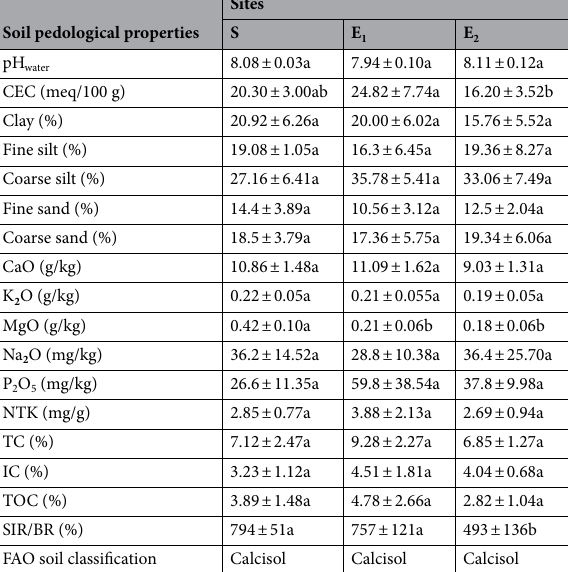
Table 1. Soil pedological properties (mean ± standard deviation) of the studied sites measured between 0 and 10 cm depth and FAO soil classification. Means (n = 5) followed by different letters are significantly different (Wilcoxon test. p ≤ 0.05). Sites: S = reference site at Sormiou. E 1 = Escalette 1 and E 2 = Escalette 2. Parameters: CEC = cation exchange capacity; NTK = total Kjeldahl nitrogen; TC = total carbon; IC = inorganic carbon; TOC = total organic carbon; SIR/BR = substrate-induced respiration/soil basal respiration.